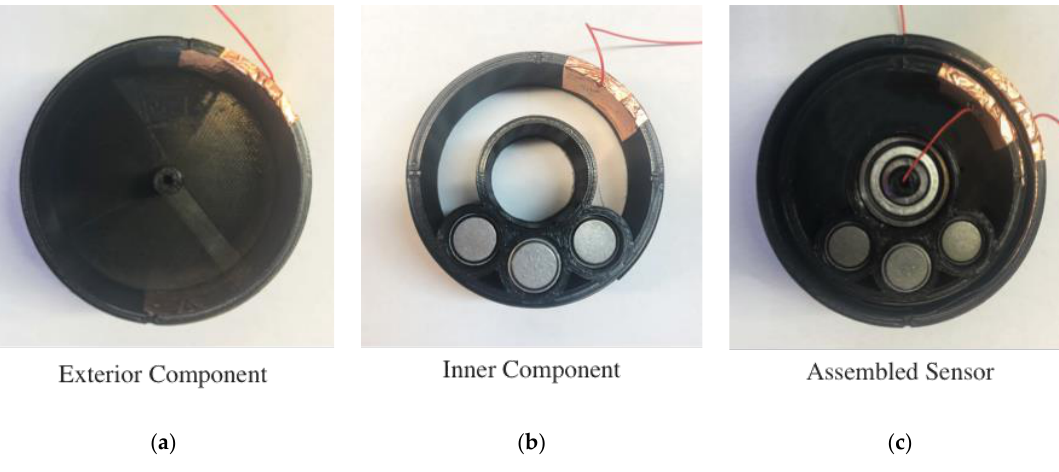
Figure 5. The 3D-printed capacitive tilt sensor consists of an ( a ) external component and ( b ) a concentrically mounted inner component with tungsten weights. ( c ) The uncovered and assembled tilt sensor with ball bearings at the interface is shown.